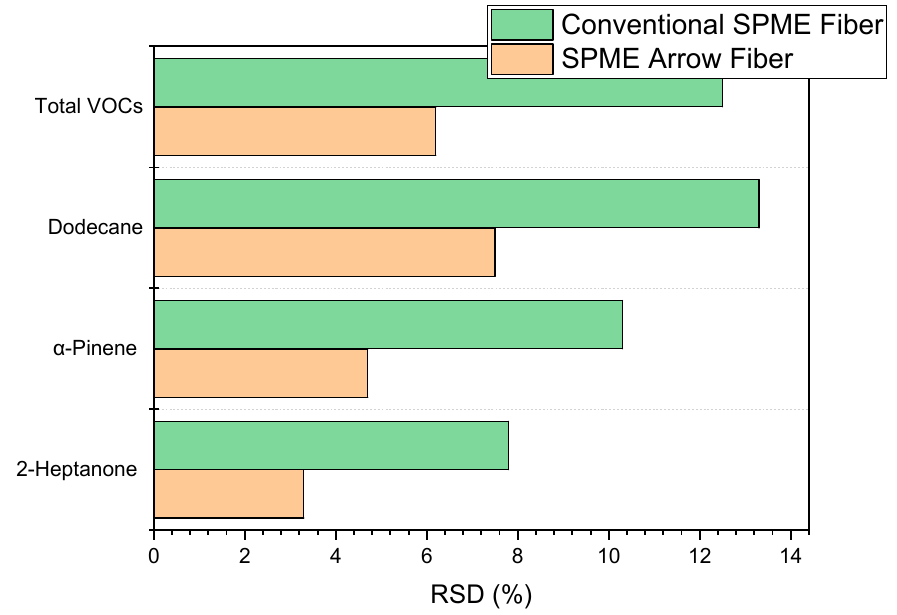
Figure 7. Reproducibility comparison for CAR/PDMS SPME Arrow fiber and conventional CAR/PDMS SPME fiber.